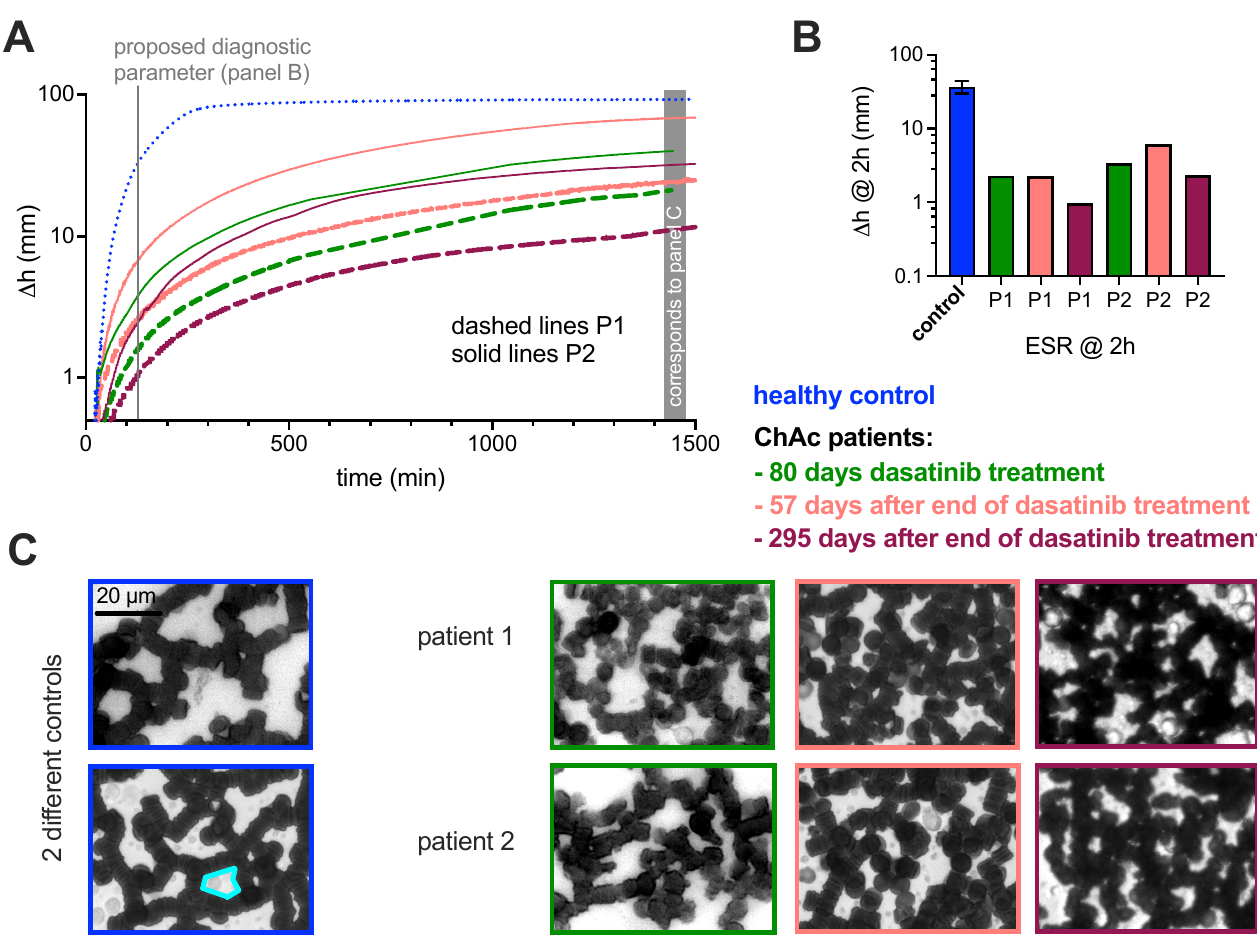
Figure 2. Measurements of the ESR with the standard Westergren method using EDTA blood. ( A ) Plots of the color-coded sedimentation curves retrieved from optical images taken every minute, i.e., the density of the data points corresponds approximately to the printed resolution. ( B ) Comparison of the sedimentation height after 2 h, which was proposed to be a diagnostic biomarker [10]. Please note that panels ( A , B ) are logarithmic plots. ( C ) Representative micrographs of sedimented RBCs forming aggregates on a coverslip. RBC are diluted in plasma, forming a hematocrit of approximately 45% in the 2D layer on the coverslip. The cyan-framed area is an example to indicate a